Question: Express in one sentence what the figure is showing.
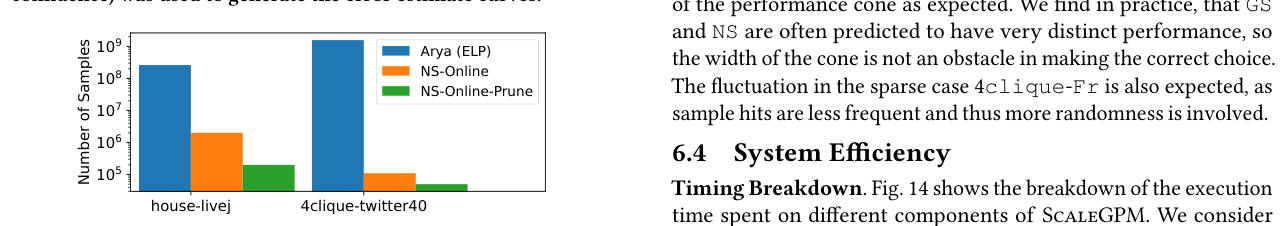
Answer: The reduction on the number of samples.